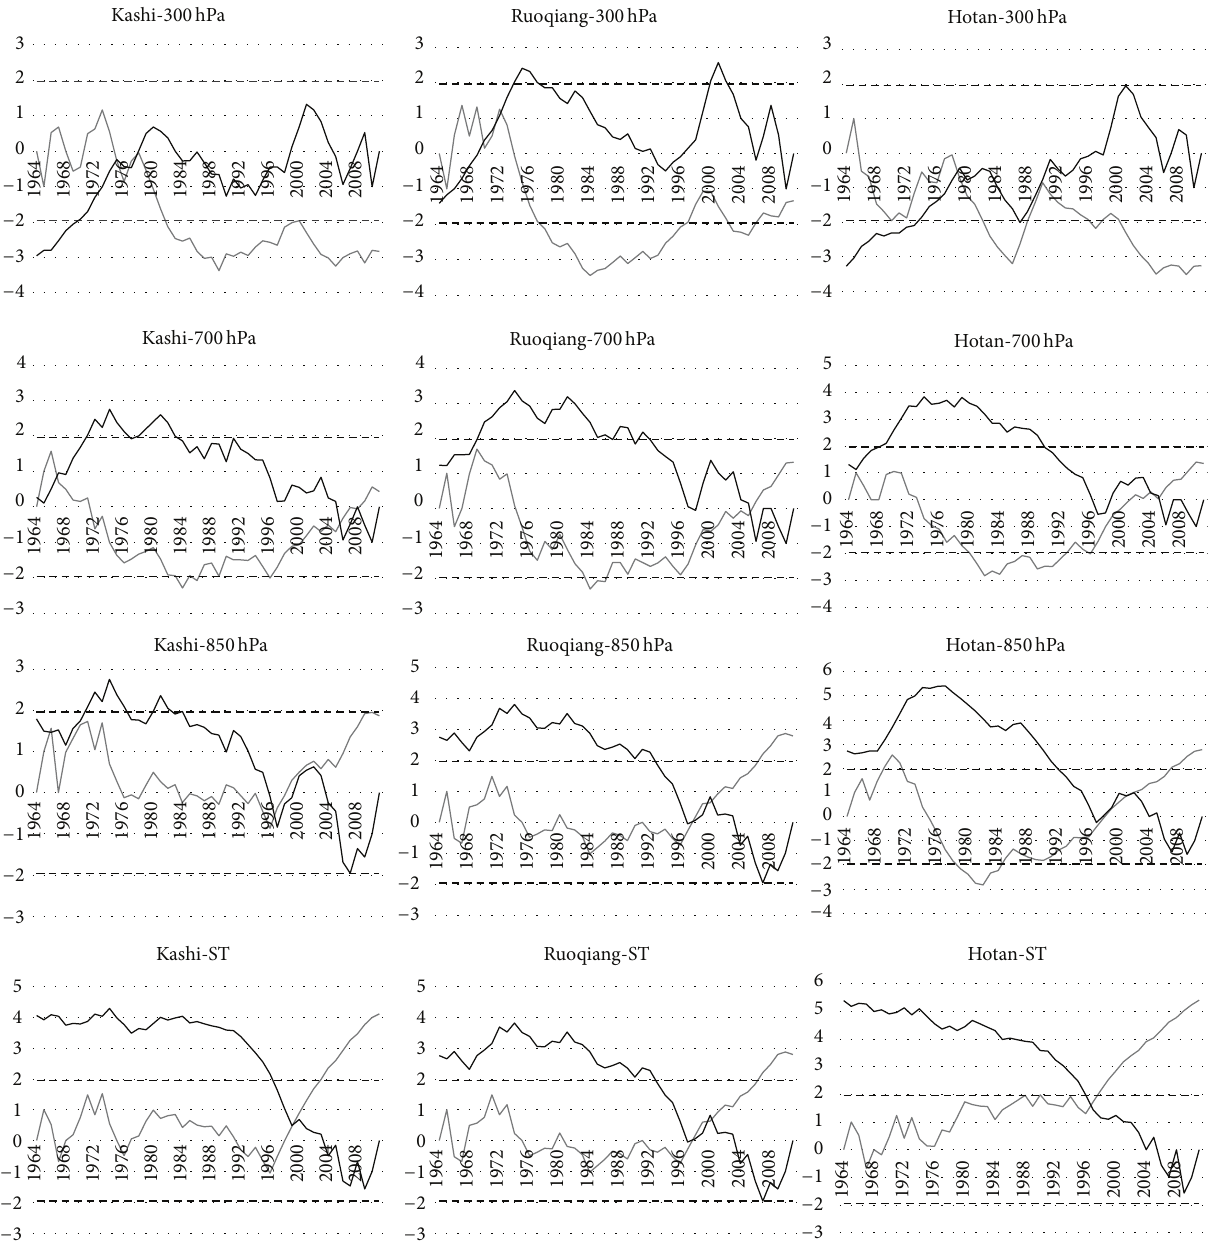
Figure 3: Abrupt change point analysis of three